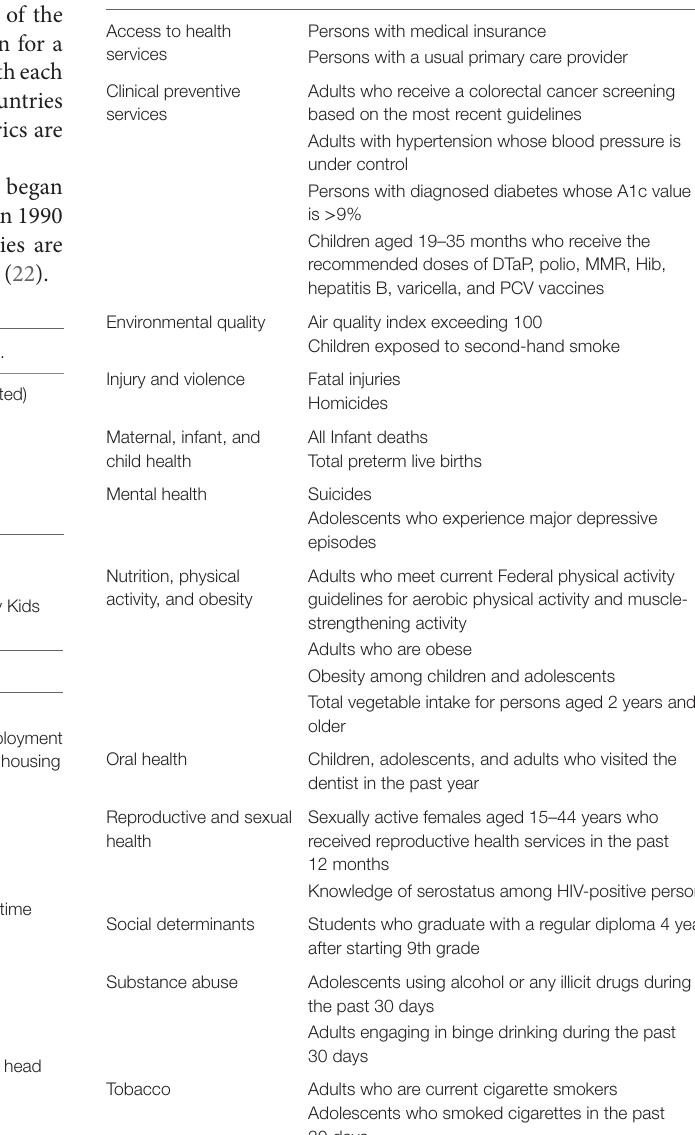
TABLe 8 | United States Healthy People 2020